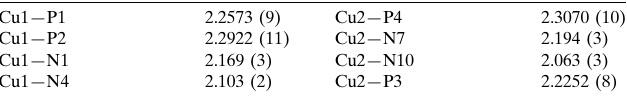
Selected bond lengths (A˚